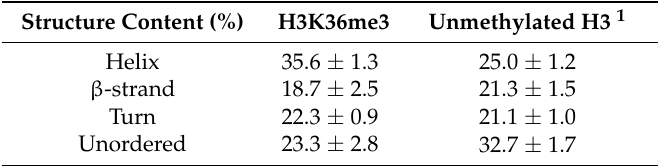
Table 1. The secondary structural contents of H3K36me3 and unmethylated H3, obtained using the SELCON3 program.